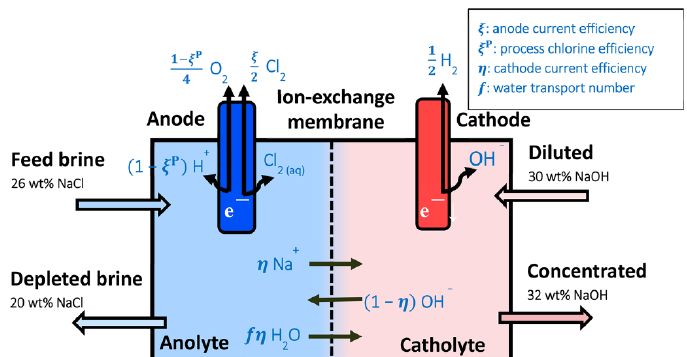
Fig. 11. – Schematic overview of a membrane-based clorine alkaline electrolyser. Figure adapted with permission from